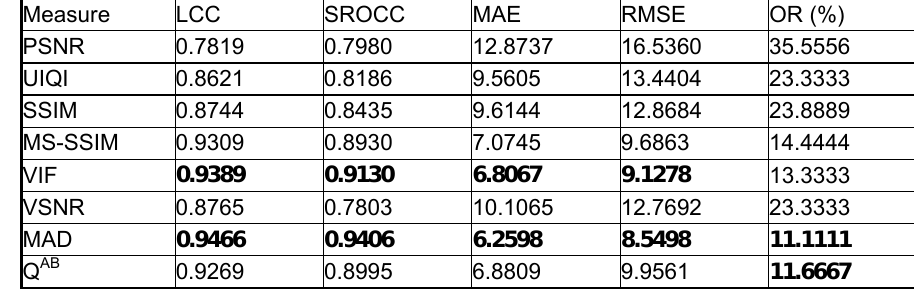
Table 1 – Performance of objective quality assessment metrics on the JPEG XR dataset Таблица 1 – Эксплутационные характеристики показателей